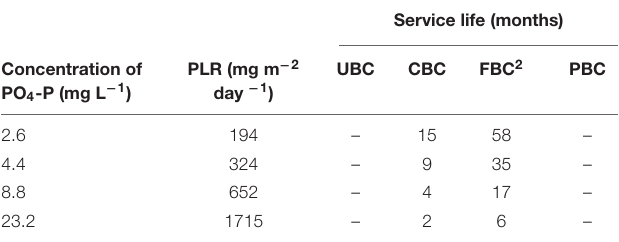
TABLE 6 | Estimated service life 1 (in months) of unimpregnated biochar filter (UBC), CaO-impregnated biochar filter (CBC), FeCl 3 -impregnated biochar filter (FBC), and biochar filter mixed with Polonite R (cid:13) (PBC) under different phosphorus loading rates (PLR) at a fixed hydraulic loading rate of 74 L m − 2